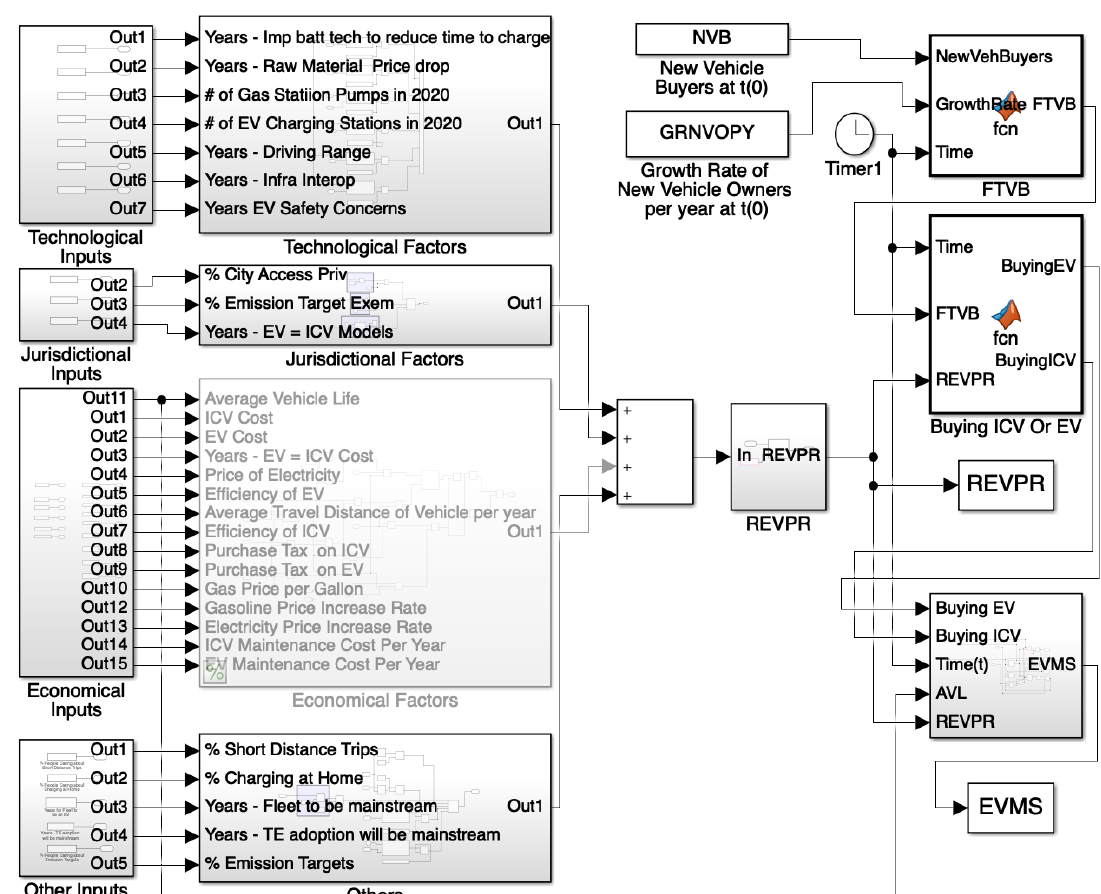
Figure 2. MATLAB-based dynamic model with configurable